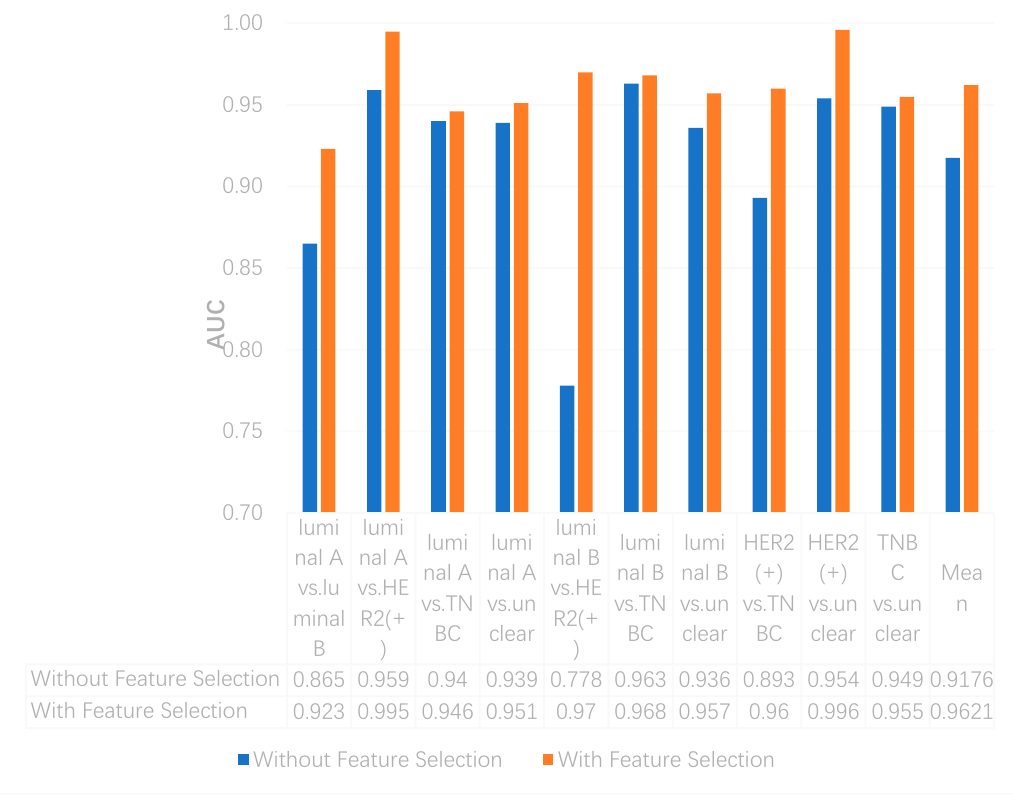
Figure 8. The AUCs of multi-omics data integration using deep neural networks with and without feature